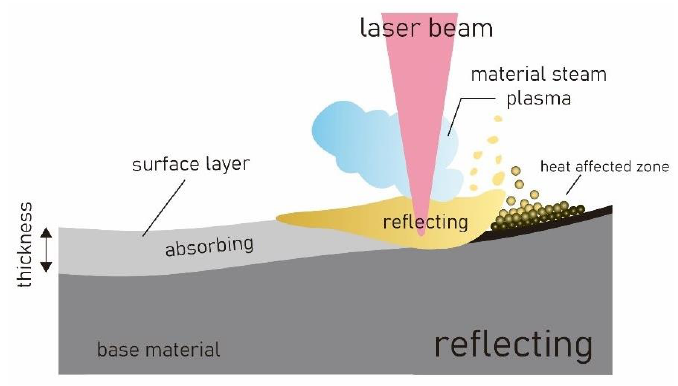
Figure 1. Laser cleaning principle.